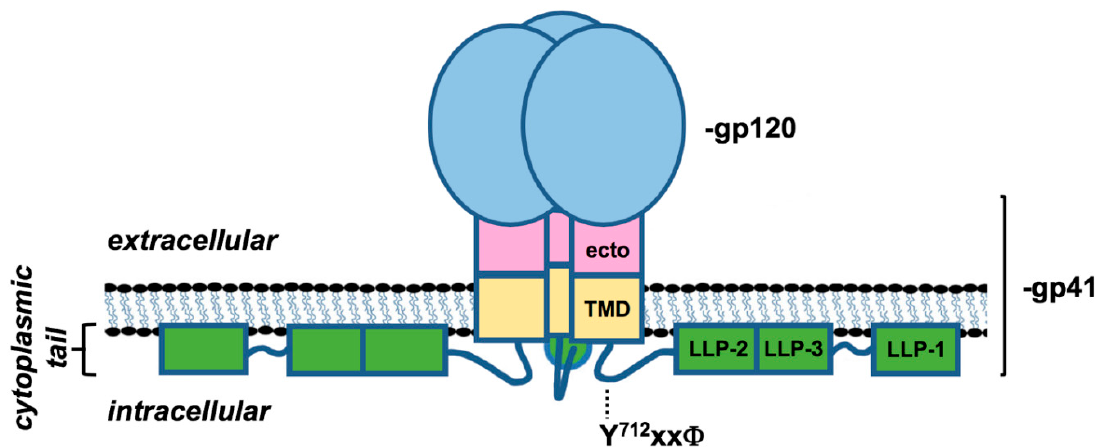
Figure 1. Schematic representation of the HIV envelope glycoprotein (Env) trimer of dimers (adapted from Tedbury and Freed [1]). The gp120 subunit is in pink and the three domains of the gp41 subunit are represented in pink, yellow, and green. The plasma membrane is indicated in black with the transmembrane domain (TMD) of gp41 spanning the membrane, bridging the extracellular gp120 subunit and the intracellular cytoplasmic tail (CT). The location of the conserved endocytosis motif, Y 712 xx Φ , is indicated with a dashed line. The location of the three lentivirus lytic peptides (LLP) in the CT are indicated along the CT.